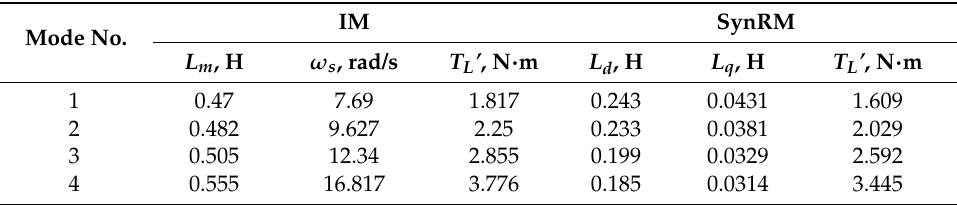
Table 9. Calculated parameters of motors in operating modes of Table 5.